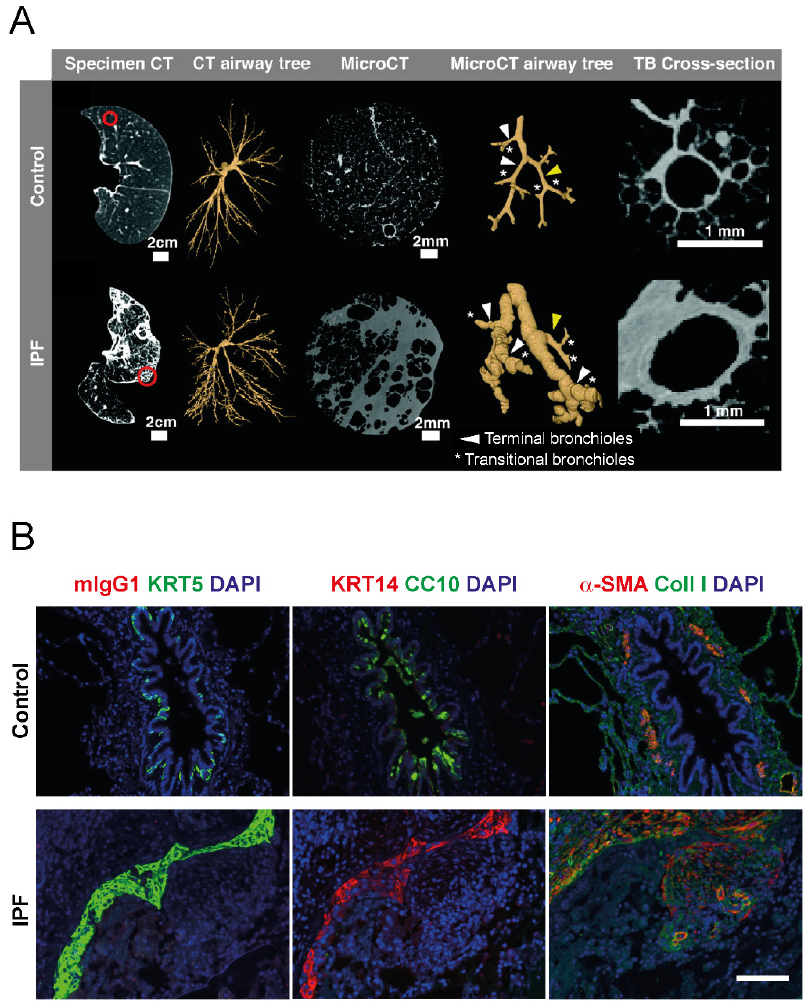
Figure 2. Airway epithelial abnormalities in IPF. ( A ) Comparison of airway features in control and IPF lungs as monitored by computed tomography (CT, adapted from Ikezoe et al. [12] with permission of the American Thoracic Society). Computed tomography (CT) scans from lungs of a control subject (upper row) and a case of IPF (lower row). The panels show from left to right: (1) Axial midslice multidetector computed tomography (MDCT) scans indicating where a random tissue sample was obtained for microCT (red circles); (2) reconstructed airway tree for the same scan from the lateral perspective; (3) midslice microCT scans of the tissue sample circled in red; (4) small airway tree segmentations obtained from the microCT scans visualized in three dimensions, identifying terminal bronchioles (TB, white arrowheads) and transitional bronchioles (asterisks); (5) representative cross-sectional image of the terminal bronchiole (TB) highlighted by the yellow arrowhead. This figure panel is adapted from Ikezoe et al. [12] with permission of the American Thoracic Society. Copyright © 2022 American Thoracic Society. All rights reserved. The American Journal of Respiratory and Critical Care Medicine is an official journal of the American Thoracic Society. Readers are encouraged